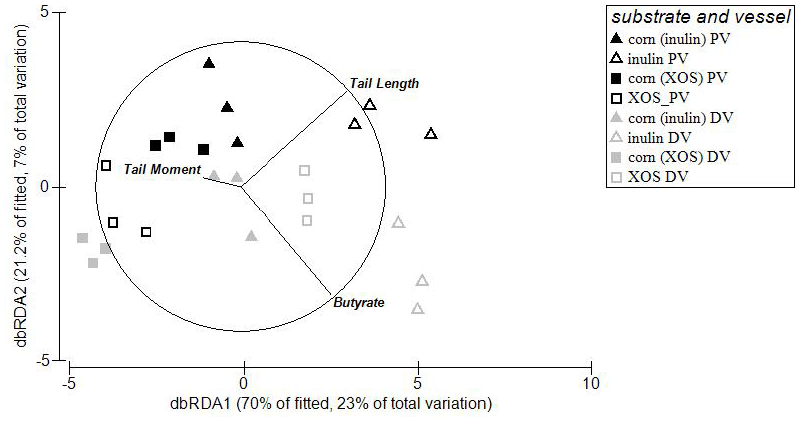
Figure 2. Distribution of the variation in the relative microbial abundance displayed based on a distance based redundancy analysis (dbRDA) with vectors indicating the weight and direction of the best predictor variables from the biochemical results. PV: proximal vessel; DV: distal